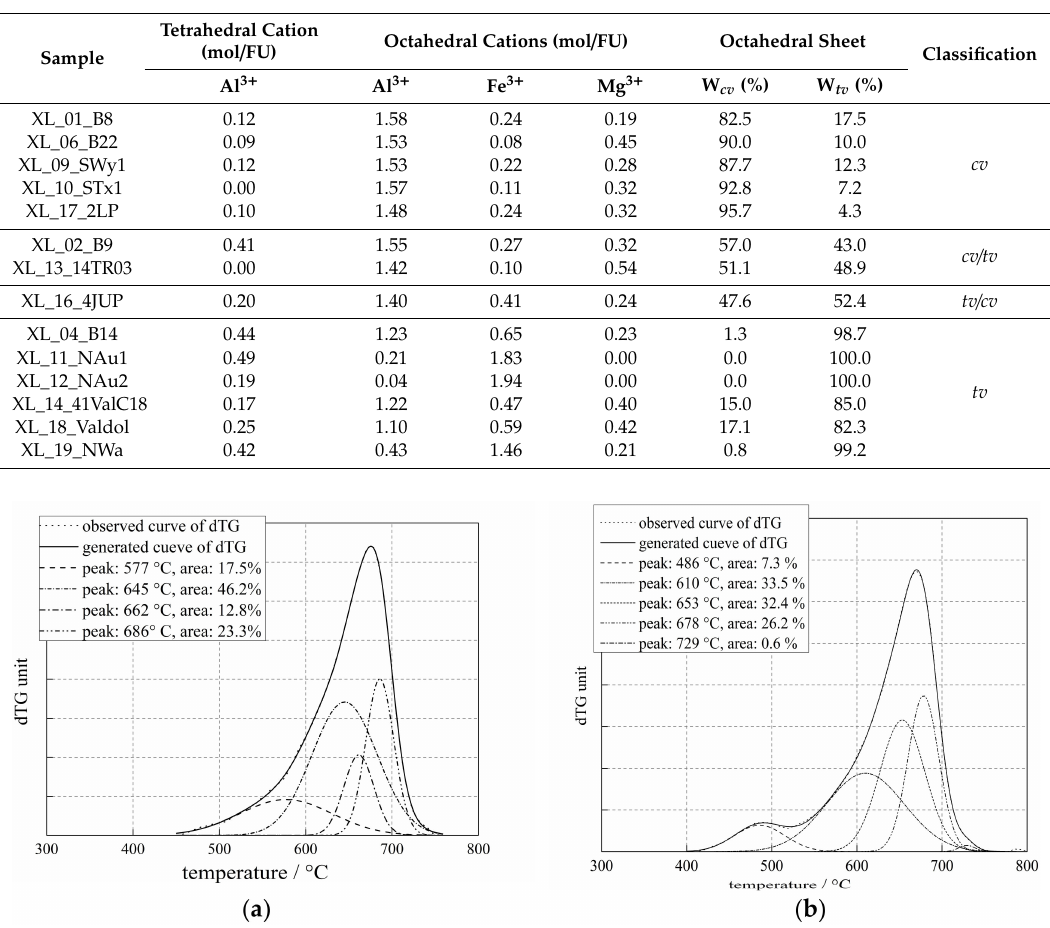
Table 4. The cations content and the proportions of trans- (W tv ) and cis- vacant (W cv ) configurations of samples and the classification.